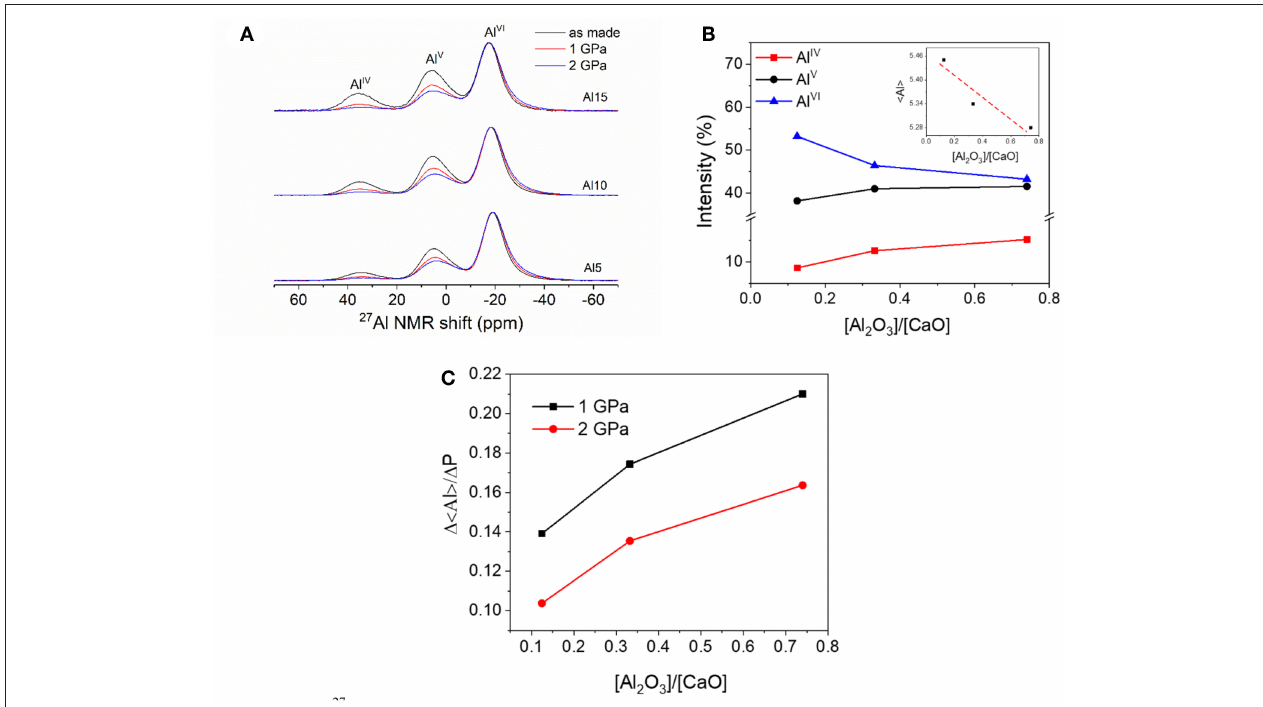
FIGURE 3 | (A) 27 Al MAS NMR spectra of as-prepared CaO-Al 2 O 3 -P 2 O 5 glasses (black) and those hot compressed at 1 GPa (red) and 2 GPa (blue). (B) Intensities of each central 27 Al NMR line as a function of the glass composition. Inset: mean coordination number for Al calculated from the NMR intensities. (C) Composition dependence of the change in the mean Al coordination ( < Al > ) per unit change in